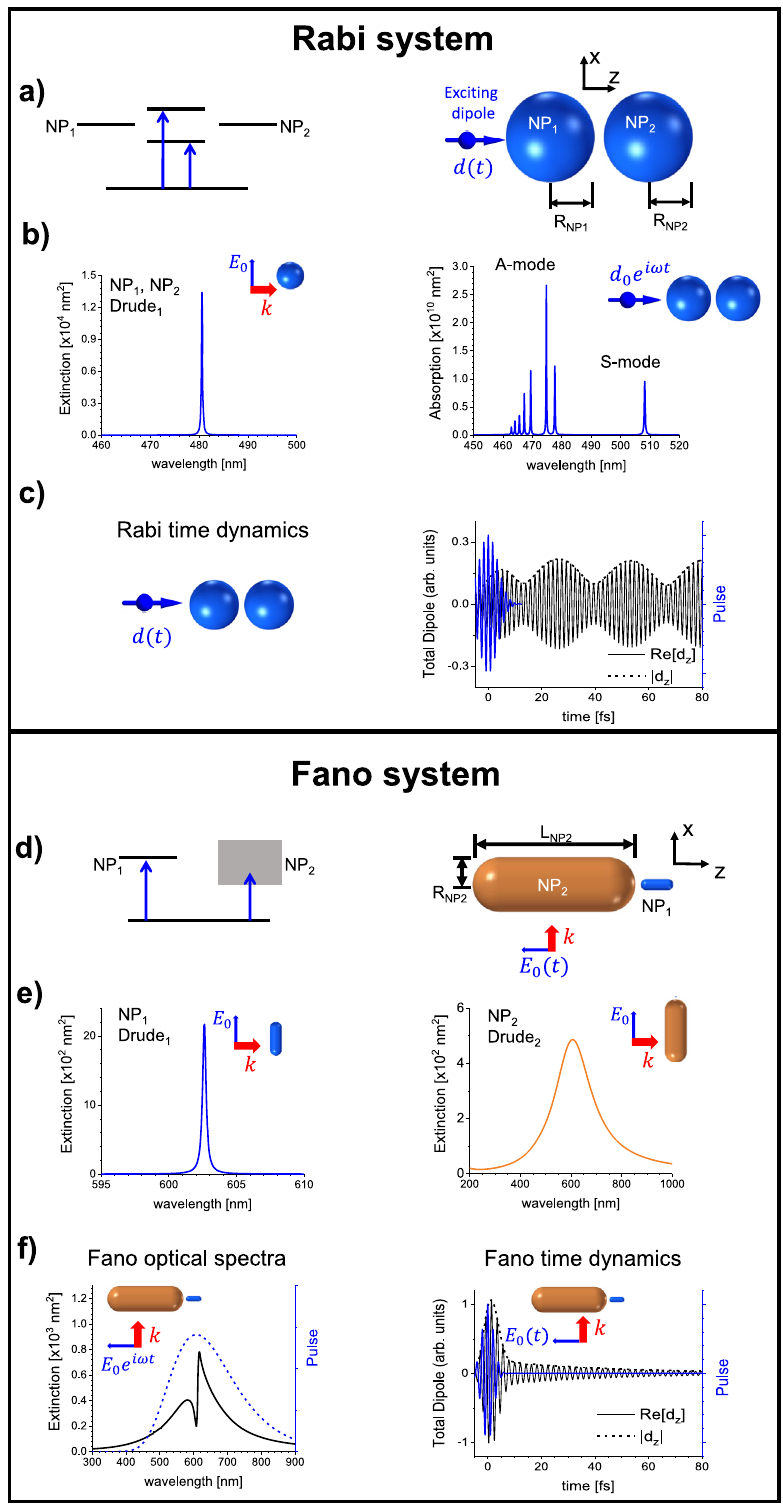
Figure 1: Schematic and properties of Drude – Rabi (a,b,c) and Drude – Fano (d,e,f) systems. (a) Energy-level scheme (left) and the geome- try of the Rabi dimer under dipole excitation (right). (b) Extinction of one isolated NP (left) and the absorption spectrum of the dimer (right). (c) Dimer ’ s time dynamics of the total dipolemoment, including the excitationpulse (blue). Similarly, in the following panels, we show the optical properties of the Fano dimer. (d) Energy diagram of the Fano dimer. (e) Ex- tinctions of isolated NPs. (f) Dimer ’ s extinc- tions and time dynamics. For the Rabi system, we used R NP1 = R NP2 = 5 nm, gap = 1 nm, Δ t = 5 fs, λ 0 = 495 nm. For the Fano system, we took R L R NP1 = 1 nm, NP1 = 6 nm, NP2 = 5 nm, L Δ t = 3 fs, and NP2 = 30 nm, gap = 1 nm, λ λ (cid:2) 2 π c / ω 0 0 . For the lin- 0 = 608 nm, where early polarized light, we assume a wave polarized along z, incoming with k || x